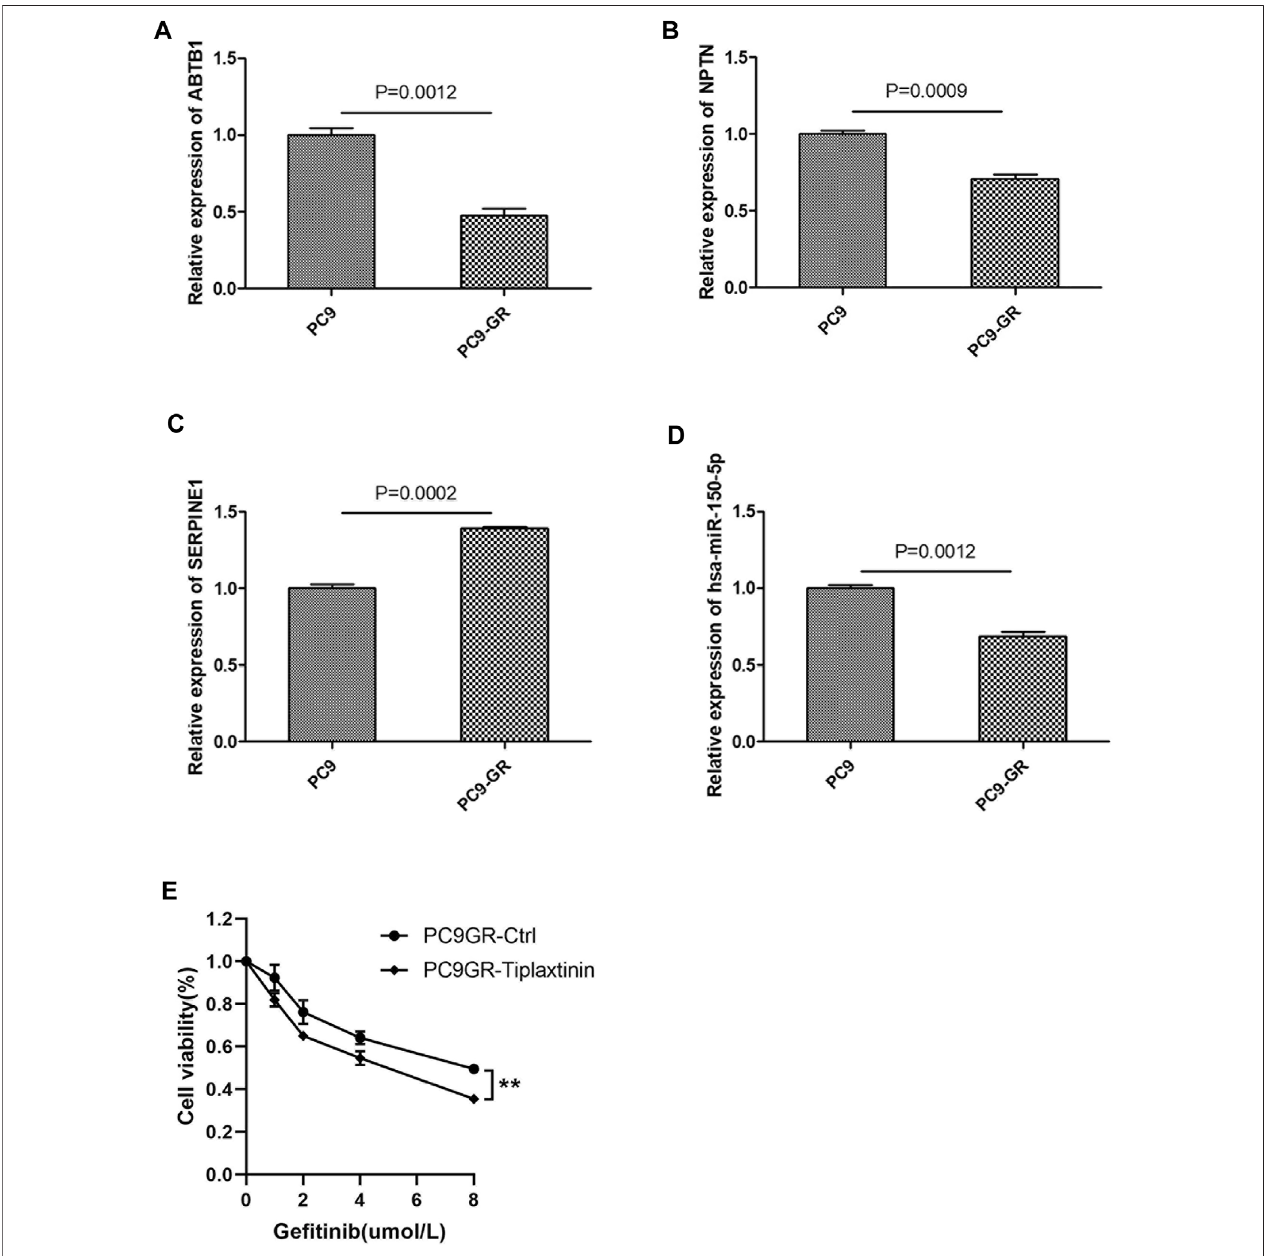
FIGURE 9 | Validation of representative core ceRNa regulatory sub-networks in human NSCLC cell lines. (A – D) Quantitative real-time PCR validation of the dysregulation of ABTB1, NPTN, hsa-miR-150-5p and SERPINE1 expression in NSCLC cell lines sensitive to EGFR-TKIs (PC9) or resistant to EGFR-TKIs (PC9-GR). (E) PC9GRandPC9GR-Tiplaxtinin(ainhibitorofSERPINE1)cellsweretreatedwithdifferentconcentrationsofge fi tinib,andcellviabilityassaywasperformedwhenthecells were cultured with ge fi tinib for 48